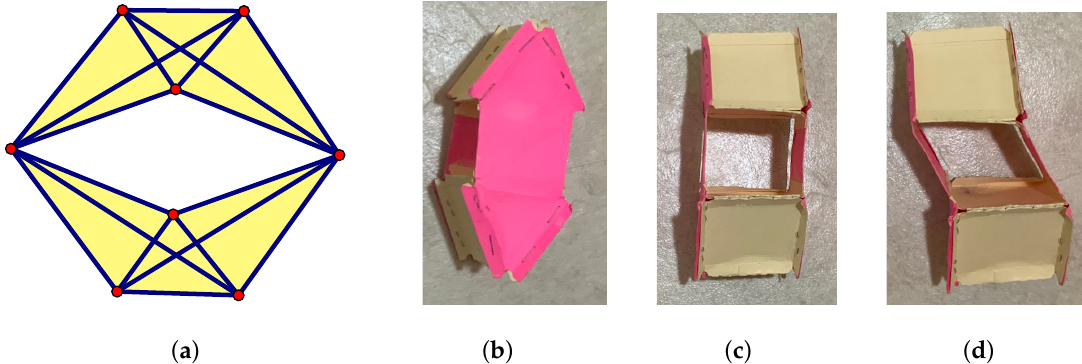
Figure 39. The polar of the double banana ( a ) as a sheetwork. Figure ( b ) is a top view of a model with a hexagon for a degree 6 vertex joining the two halves. The two triangles polarize to rigid triangular prisms joined by the two hexagons ( c , d ). This sheetwork has a finite motion which bends the two sheets along fold lines.